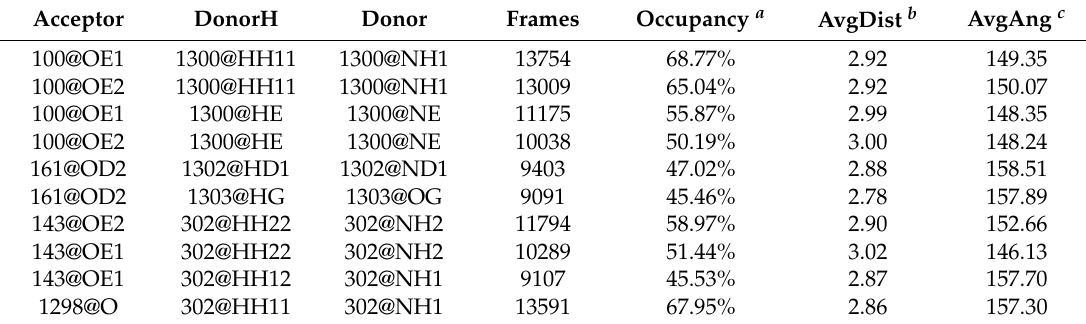
Table 3. Analysis of hydrogen bond interactions between DAPK1 and GluN2B-CT 1290–1310 complex 1 .